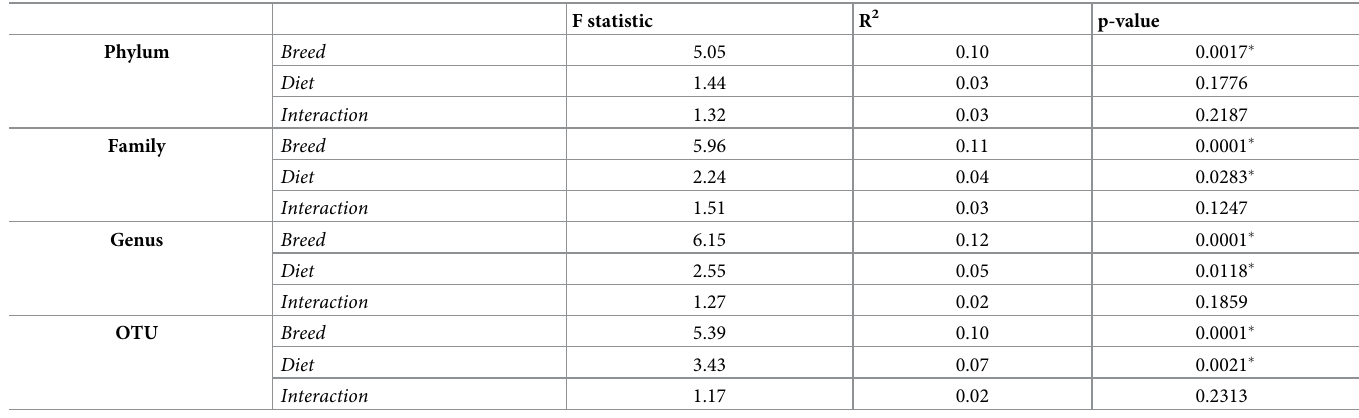
Table 3. PERMANOVA